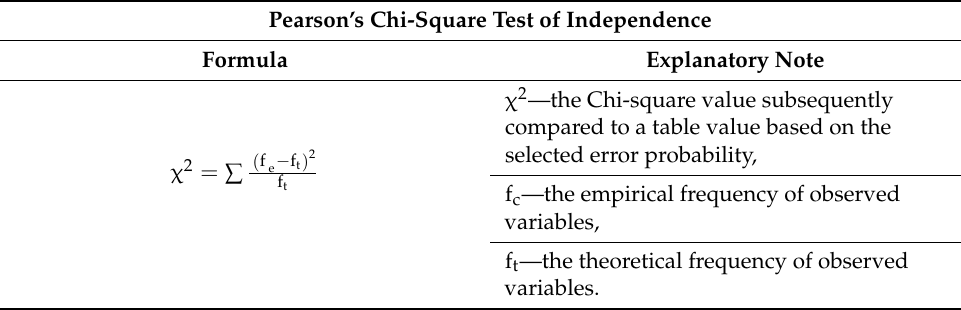
Table 1. Formulas for verifying the hypotheses. Source: (Markechov á et al. 2011). Pearson’s Chi-Square Test of Independence